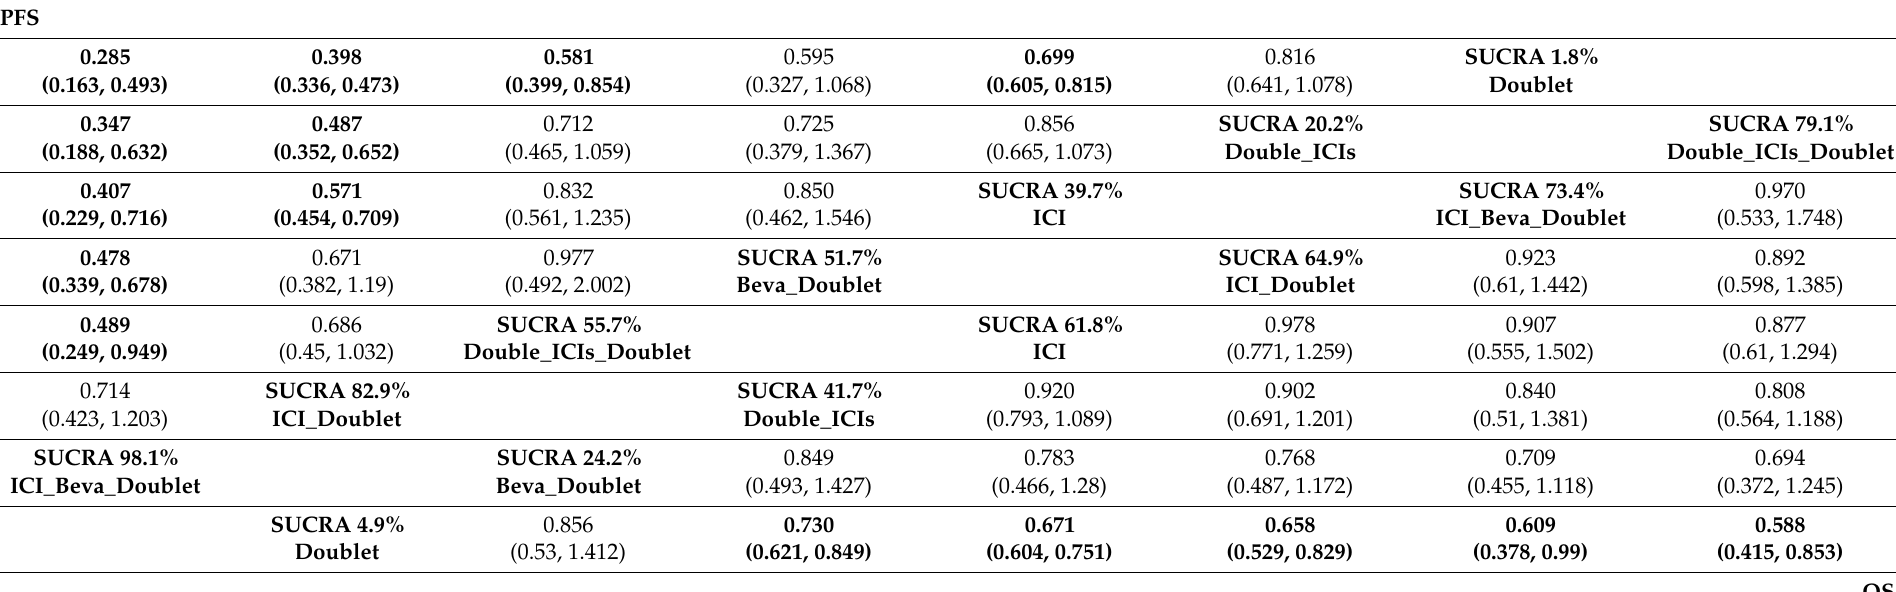
Table 2. The league table for the relative effects of all pairs of the network nodes and ranking for the probability of each network node to be the best for PFS and OS based on the SUCRA